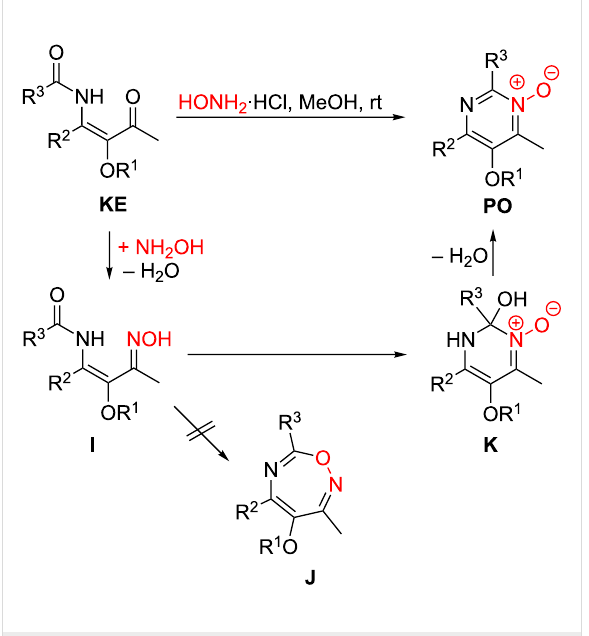
Table 5: Preparation of pyrimidine N -oxides PO1 – 25 through condensation of β -ketoenamides KE with hydroxylamine hydrochloride. a